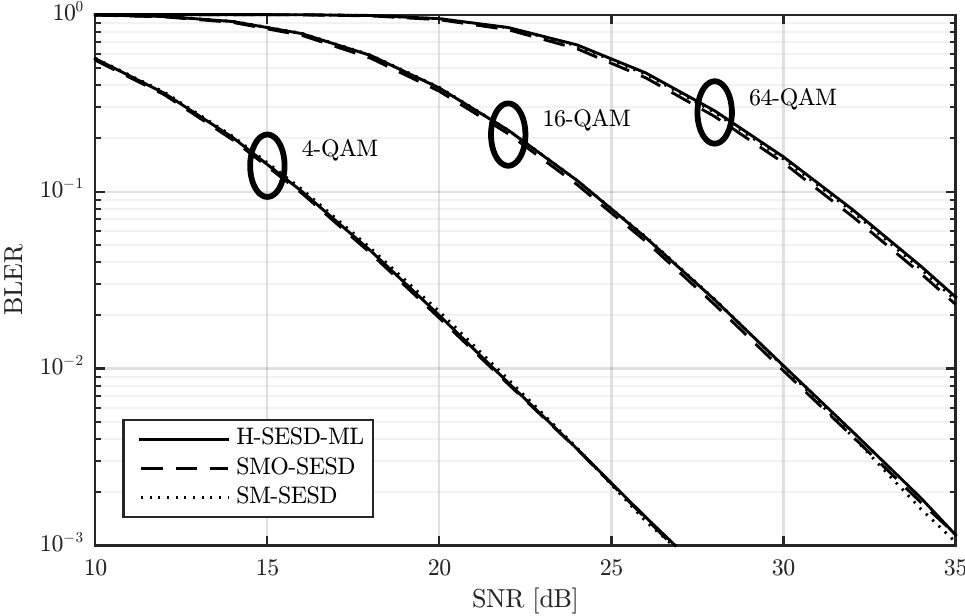
Figure 10. Performance comparison of three PSAMs constructed from rectangular QAM, their orthonormalization, and a constellation constructed using the hypercube method with the same QAM. All results are obtained for a channel with T = 8 and M = N =